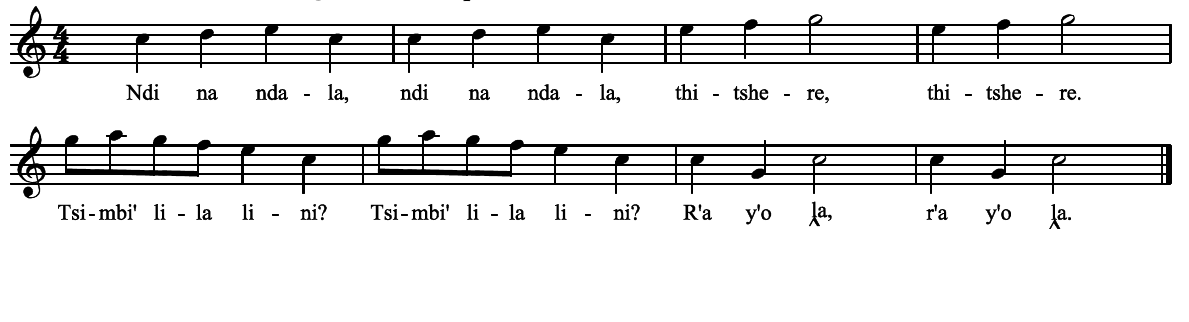
Fig. 5. Frère Jacques: alternative Tshivenda